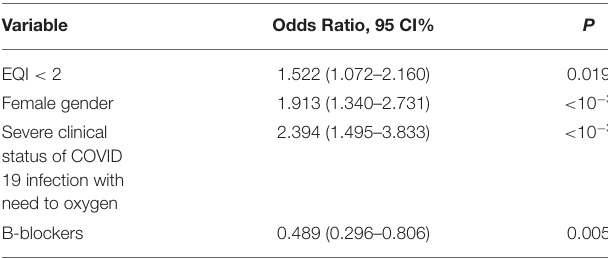
TABLE 3 | Associated factors to long COVID-19 syndrome in multivariate